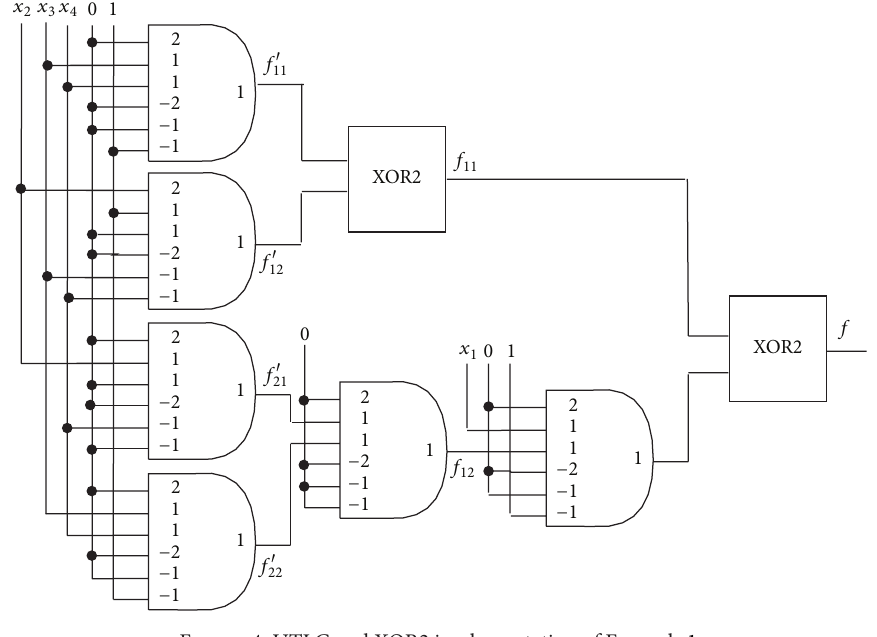
Figure 4: UTLG and XOR2 implementation of Example 1.